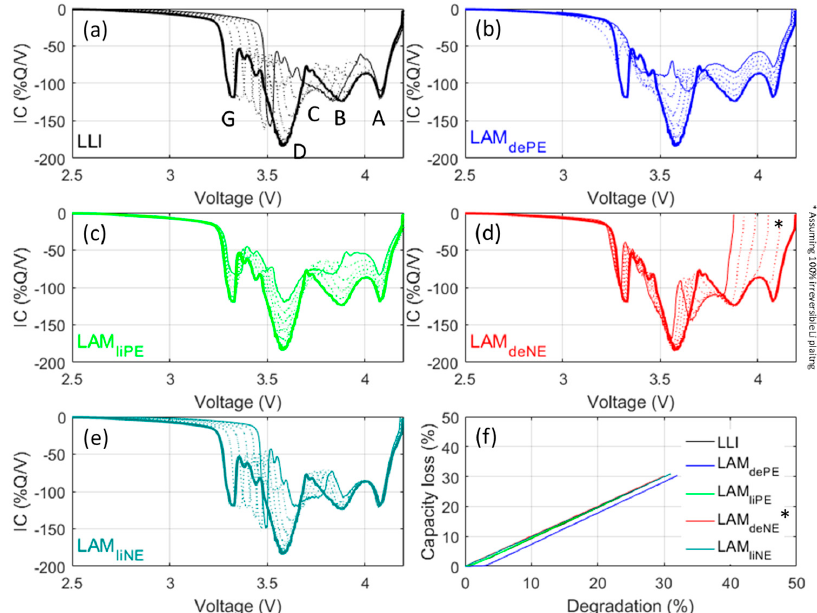
Figure 8. (Color online) Emulation at a C/35 discharge rate of effects on IC curves induced by each of the five degradation modes: ( a ) loss of lithium inventory (LLI); ( b ) LAM dePE ; ( c ) LAM liPE ; ( d ) LAM deNE ; and ( e ) LAM liNE , from 0% (full thick line) to 30% (full thin line) with 5% increments (dashed lines); and ( f ) the associated capacity loss. LAM: loss of active material.